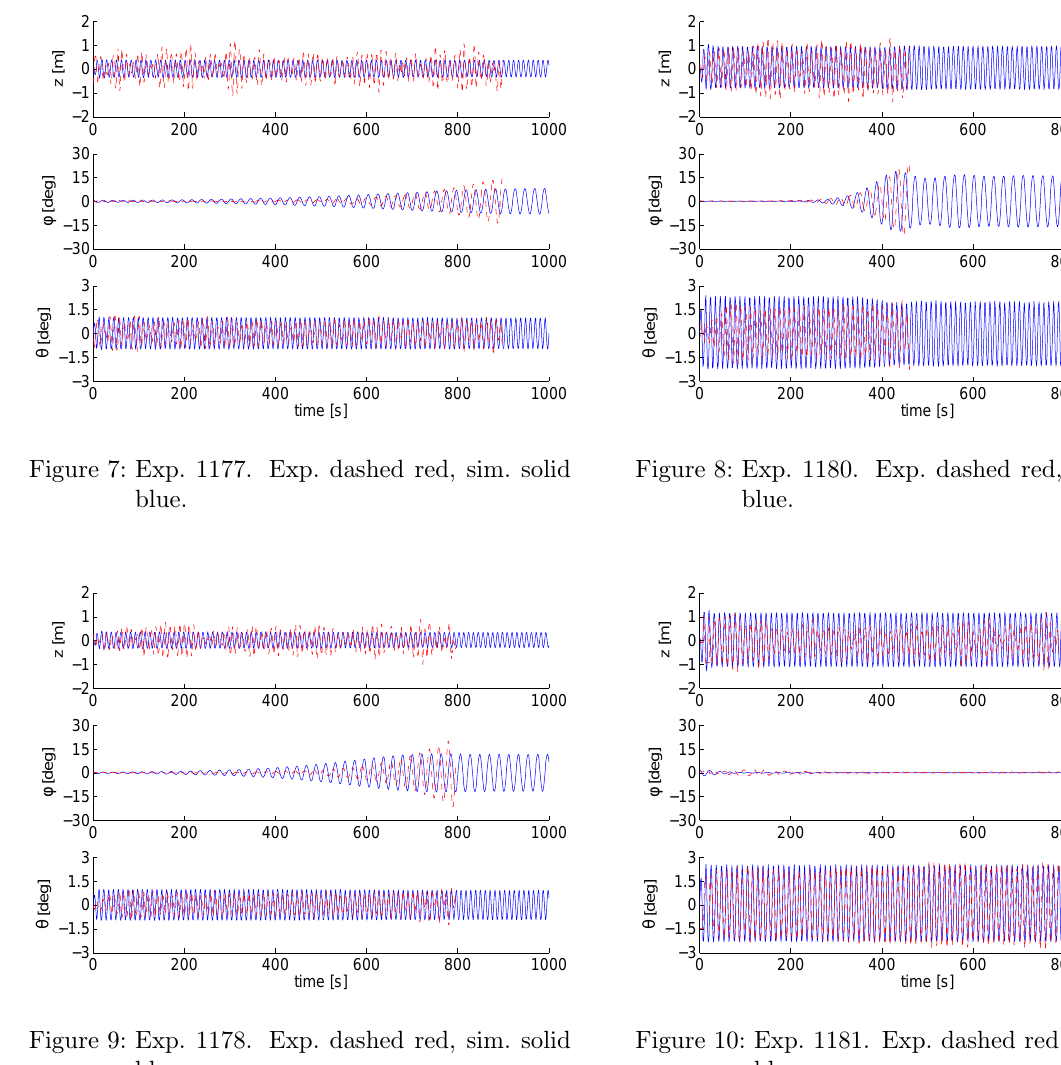
Figure 10: Exp. 1181. Exp. dashed red, sim. solid blue.